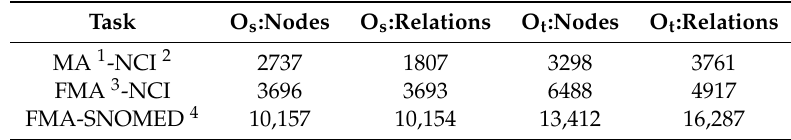
Table 1. Respective sizes of the ontology matching